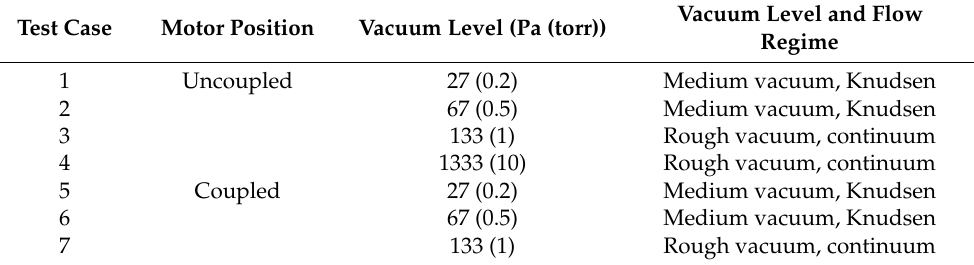
Table 2. Experiment treatment combinations for all experiments